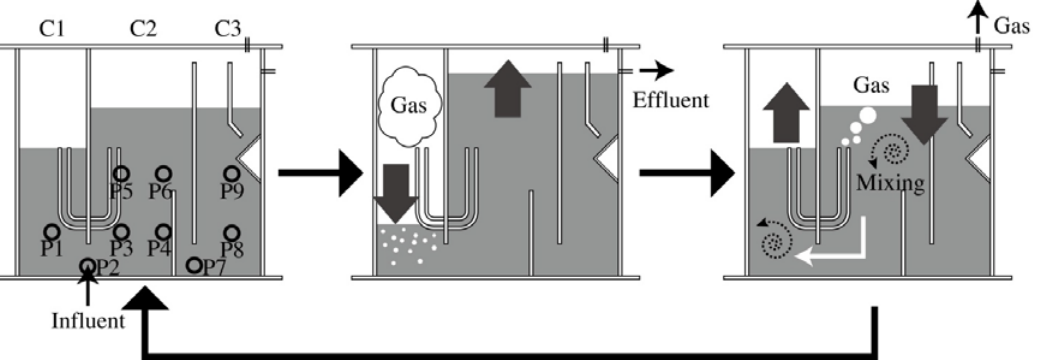
Figure 4. Experimental apparatus and the cycle of the siphon